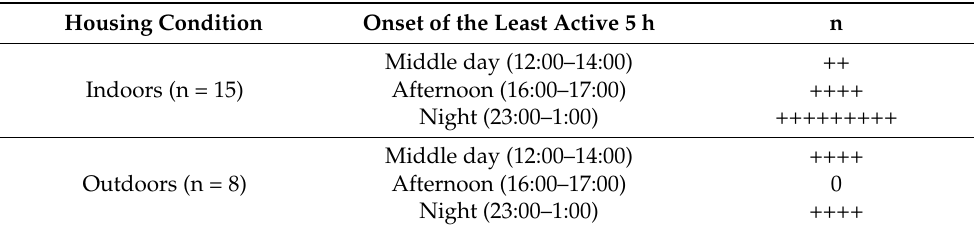
Table 1. Time of onset of the Least active 5 h of the cats according to their housing condition. (+) represents one